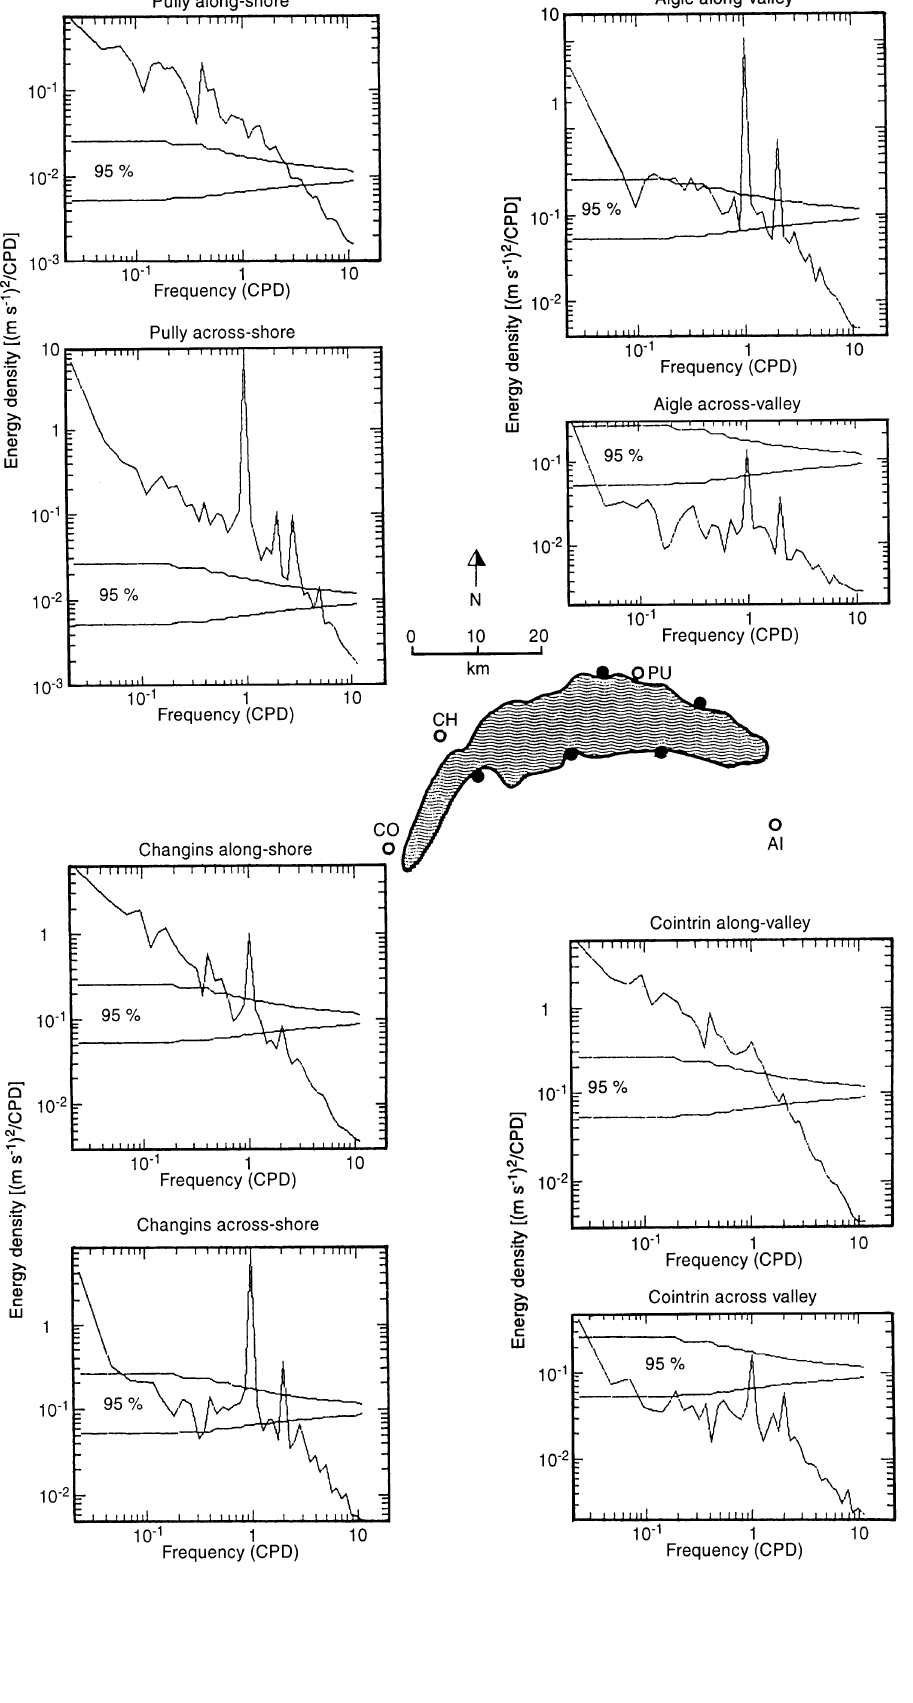
Fig. 4 . For the summer of 1985: spectra of the two components of the wind vector at the four Swiss Meteorological stations CO , CH , P ” and